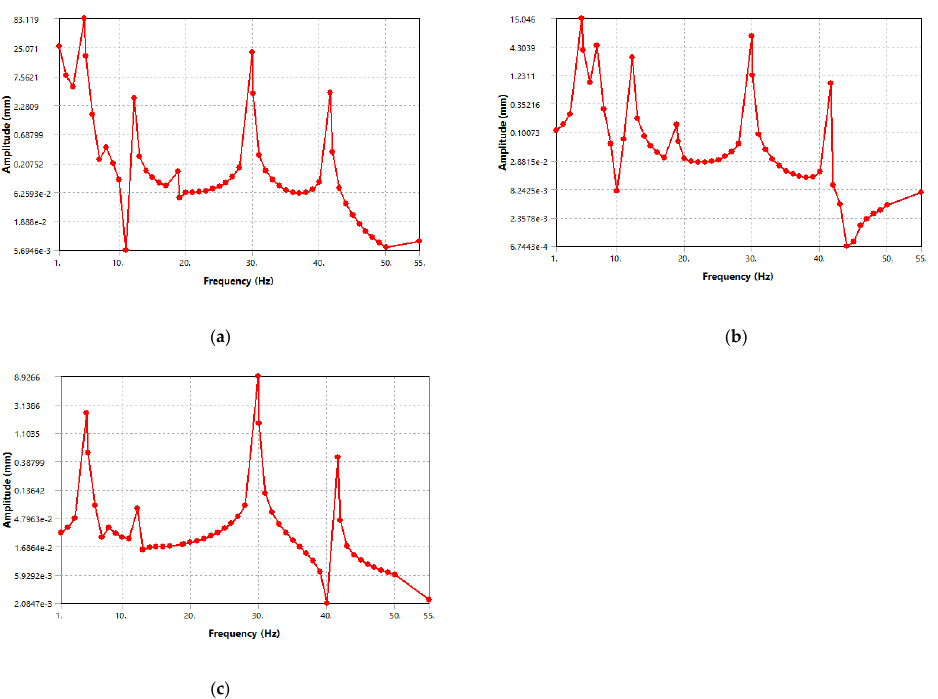
Figure 19. Frequency response of the harmonic analysis for the end-effector deformation in vertical ( a ), lateral ( b ) and axial ( c ) directions. External base excitation were sinusoidal accelerations with frequencies close to the natural frequencies, as listed in Table 4.